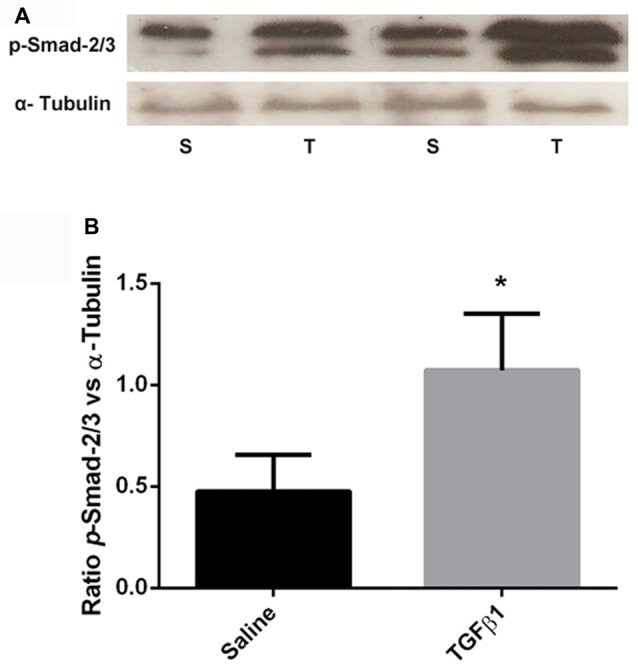
A single acute systemic injection of TGF-β1 regulates its brain intracellular signaling. Panel (A) shows the representative Western blot images showing the increased expression of p-Smad-2/3 in TGF-β1 (T) injected group compared to saline (S) injected group. (B) The quantification of the Western blotting data (ROD ratio of p-Smad2/3 over α-tubulin). A significant increase in p-Smad-2/3 was observed in TGF-β1 injected group as compared to saline injected group (*p = 0.011; n = 4 per group).